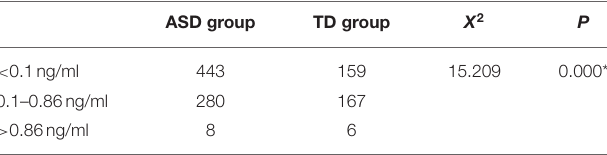
TABLE 1 | Comparison of menaquinone-4 levels between the ASD group and the TD group.